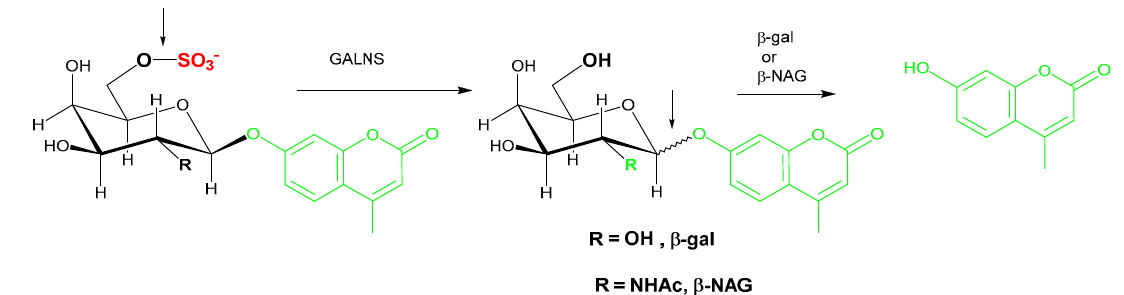
Figure 5. Illustration of the two-step GALNS reaction. In the first step of the reaction, the 4-methylumbelliferyl- β - D -galactopyranoside-6-sulfate substrate is cleaved by GALNS to remove the sulfate group and produce 4-methylumbelliferyl-galactoside. Exogenous β -gal or β -NAG is required to liberate the fluorochrome from 4-MU. GALNS: N -acetyl galactosamine-6-sulfatase; β -gal: β -galactosidase; β -NAG: β - N -acetyl-glucosaminidase.